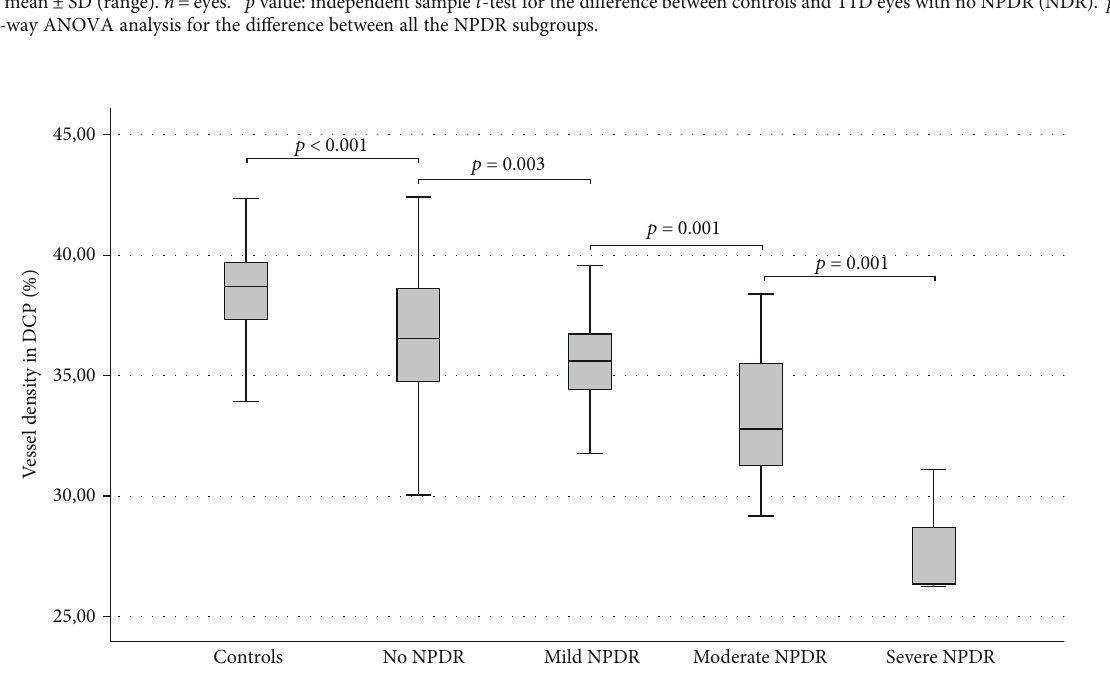
Values are mean ± SD (range). n = eyes. ∗ p value: independent sample t -test for the di ff erence between controls and T1D eyes with no NPDR (NDR). ⱡ p value: global one-way ANOVA analysis for the di ff erence between all the NPDR subgroups.